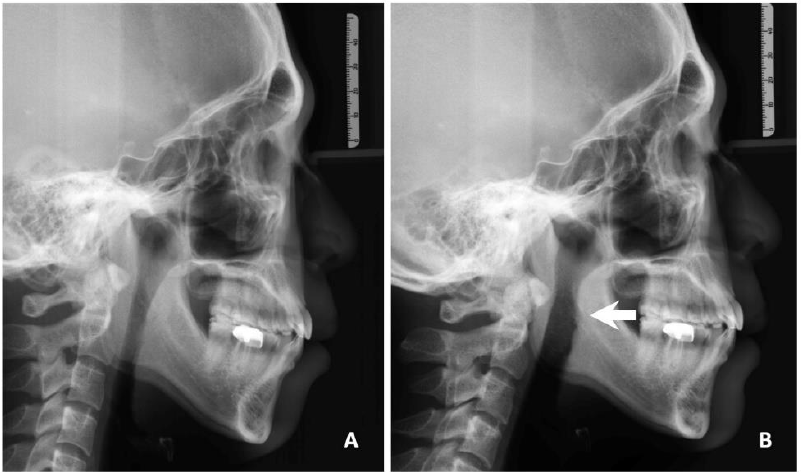
Figure 7. Change of hypopharyngeal space (arrowhead) before ( A ) and after ( B ) transoral tongue suspension plus uvulopalatopharyngoplasty in lateral cephalometry.